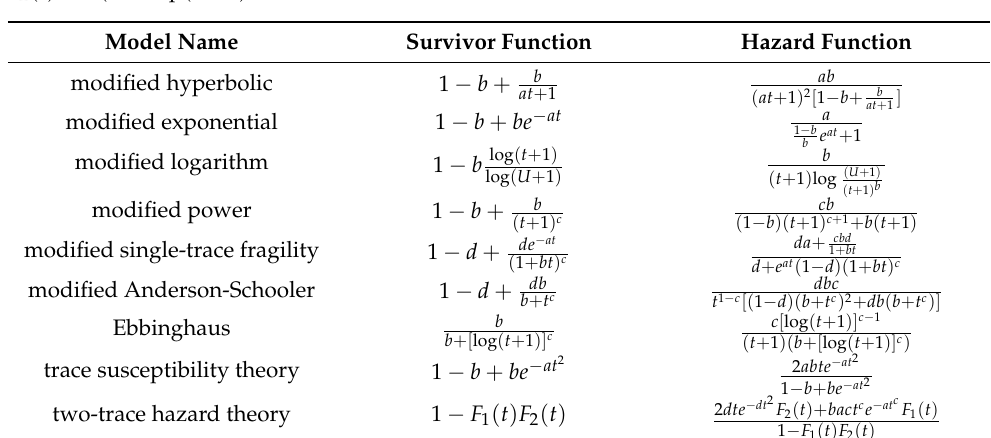
Table 1. Nine candidate models for the memory survivor function S ( t ) are shown along with the corresponding hazard function. The parameters a , b , c and d are positive. The cumulative functions for the two respective traces of the two-trace hazard model are F 1 ( t ) = 1 − exp ( − d t 2 ) and F 2 ( t ) = b ( 1 − exp ( − at c )